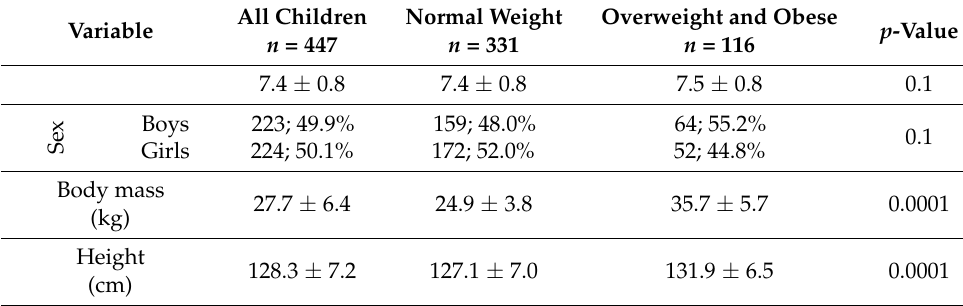
Table 1. Anthropometric variables of children included in the